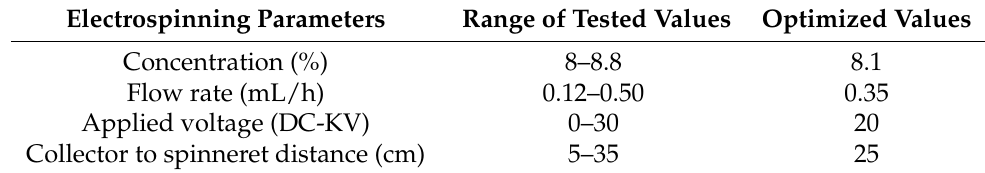
Table 2. Spinning parameter values with